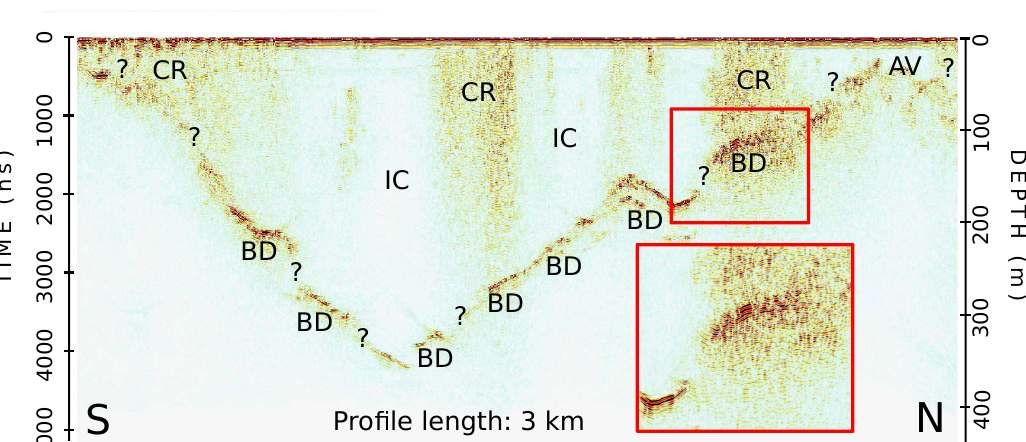
Figure A2. ( a , b ) Average Surface Velocity (md − 1 ) in the time frame 22 February 2017 until 27 March 2017 for ( a ) without filtering and ( b ) by applying the additional filter using the standard deviation in a 21 × 21 pixel window. ( c ) Flow direction ( ◦ ) of the velocity vector in the time frame 22 February 2017 until 27 March 2017, clockwise beginning from north. Background image: Landsat-8 (20 February 2017, courtesy of the U.S. Geological Survey).